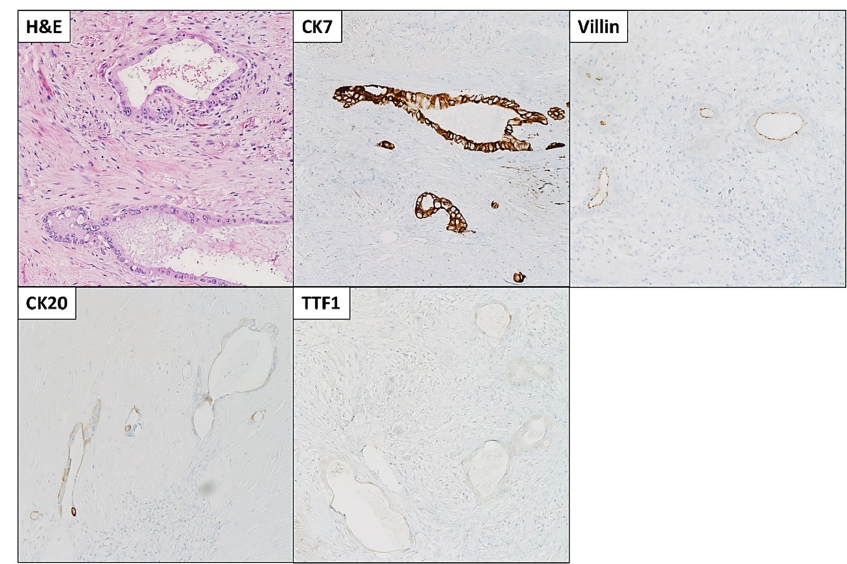
Figure 3. Gross images of the resected pancreatic tumor. ( A ) Segment of distal pancreas (black ar- row) with attached spleen (red arrow) and attached hilar adipose tissue. ( B ) Cut section through the tail of pancreas revealed a 3 cm firm mass (white arrow) with a white-to-yellow indurated cut sur- face.